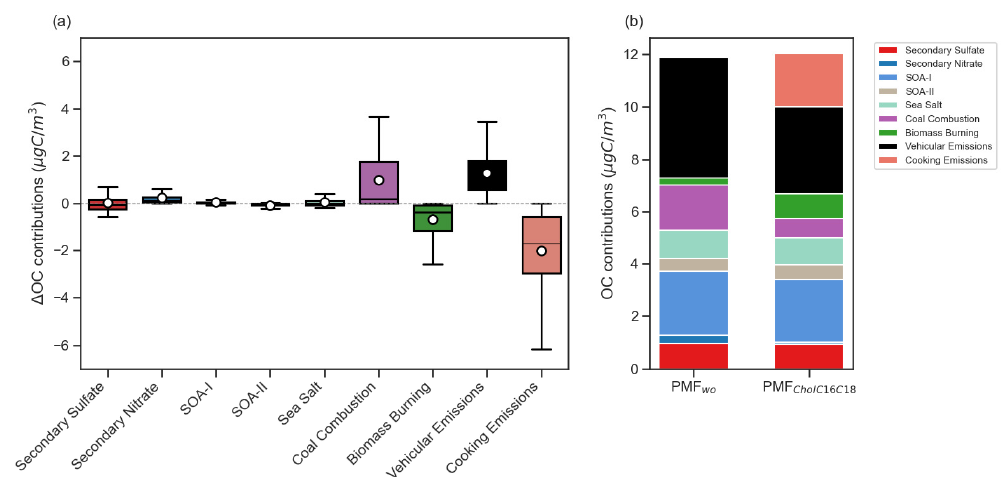
Figure 11. ( a ) Boxplot of modeled OC contribution differences (PMF wo –PMF CholC16C18 ) (µg/m 3 ) for individual factors. ( b ) Modeled OC contributions (µg/m 3 ) from PMF wo and PMF CholC16C18 .